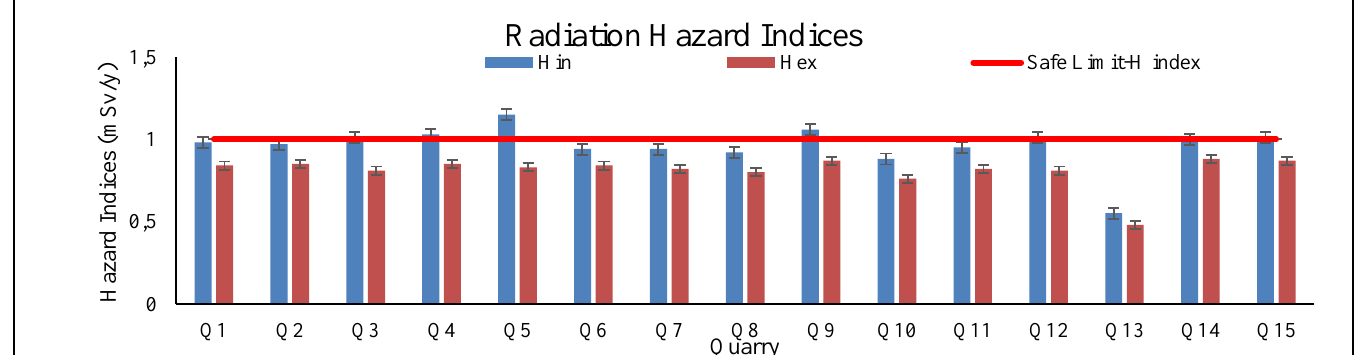
Figure 3: Hazard Indices of the Collected Rock Samples from Kericho County